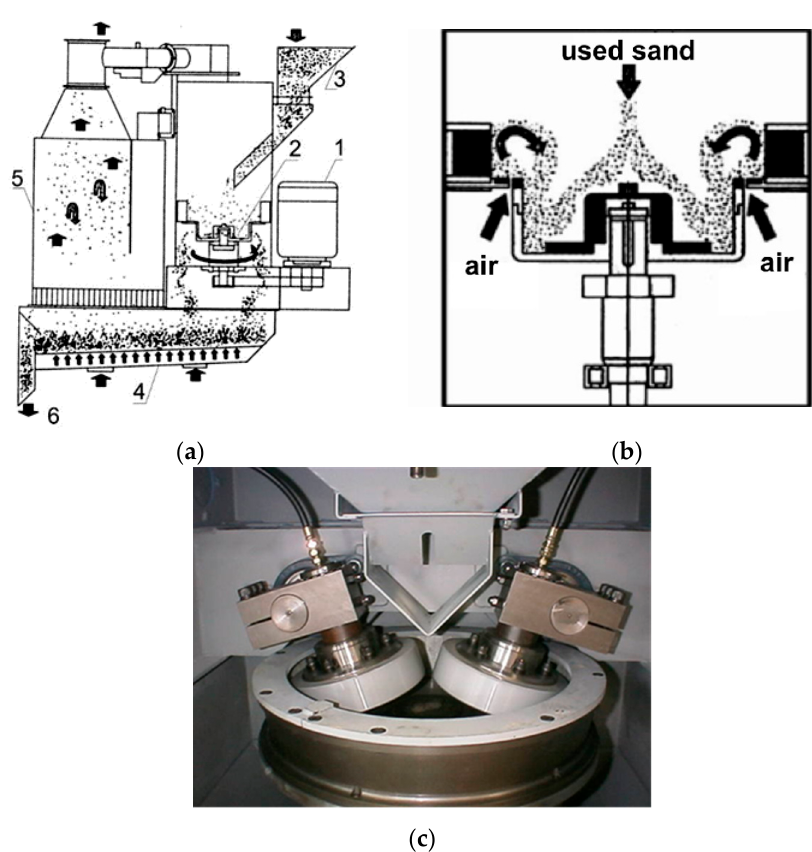
Figure A6. Diagram of the USR-I centrifugal device with cyclic operation, intended for regeneration of used sands: ( a ) regenerator scheme: 1—drive motor, 2—regenerator working unit, 3—used mass tank, 4—fluidization and dedusting gutter, 5—classifier chamber, 6—regenerate discharge; ( b ) regenerator centrifugal batch assembly. Arrows indicate directions of air flow during sand portion introduction and regeneration; ( c ) USR-I regenerator working batch [3].